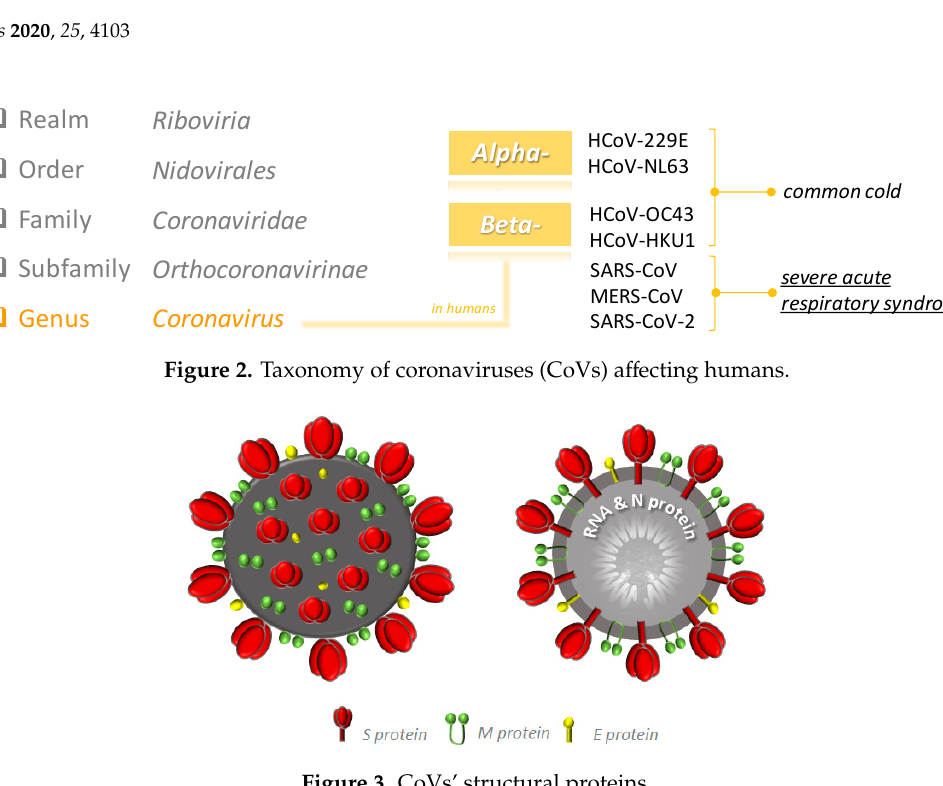
Figure 3. CoVs’ structural proteins.